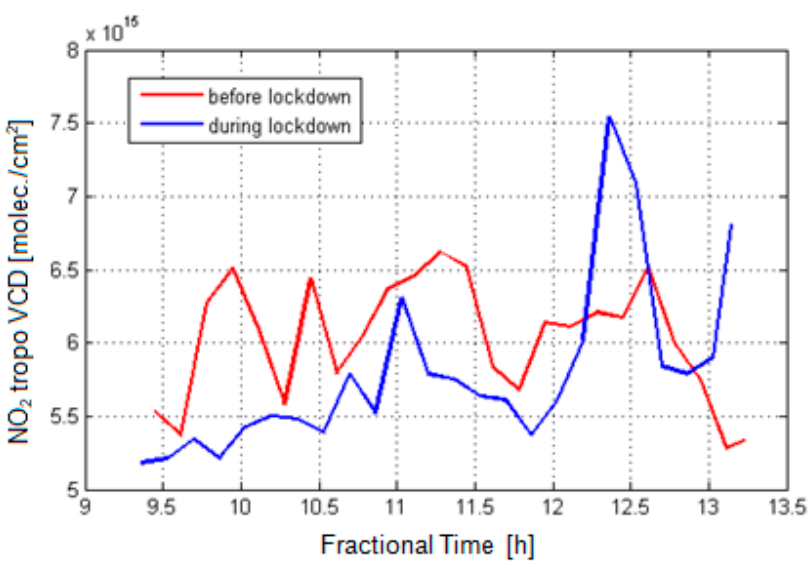
Figure 7. Comparison of the retrieved NO 2 VCD tropo with NO 2 differential slant column density (DSCD) for 11 February 2020 and 2 April 2020, derived from mobile DOAS observations over Galati city.